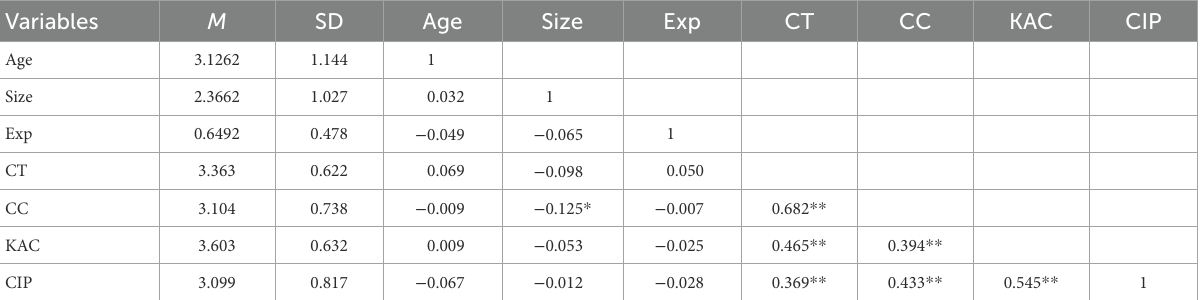
TABLE 4 Correlation analysis results of research